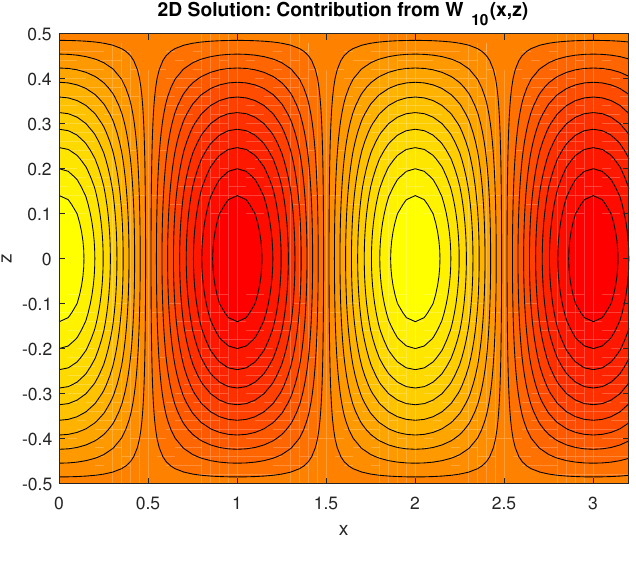
Figure 10. Solution for W 10 ( x , z ) .